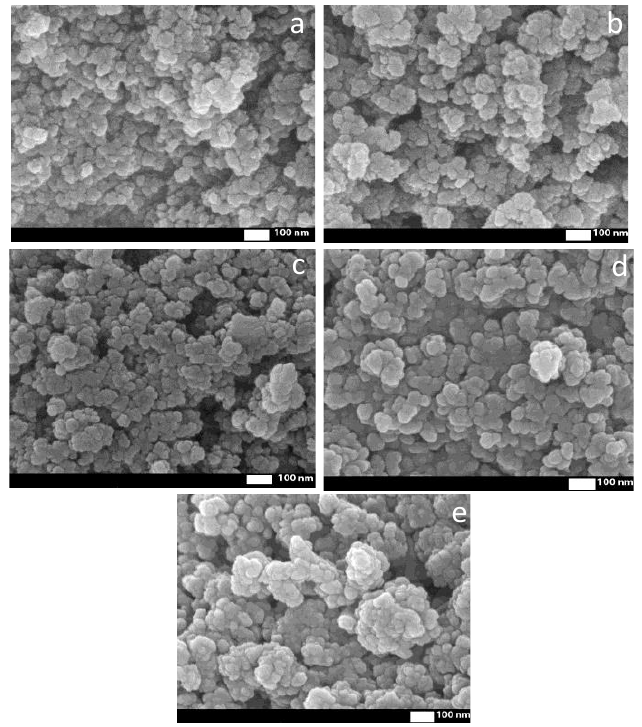
Figure 2. SEM images of Fe 3 O 4 ( a ), Fe 3 O 4 -TMSPM ( b ), Fe 3 O 4 -TMSPM-PAA ( c ), Fe 3 O 4 -TMSPM- PAA/PALAm ( d ), Fe 3 O 4 -TMSPM-PAA/PALAm-Gd ( e ).